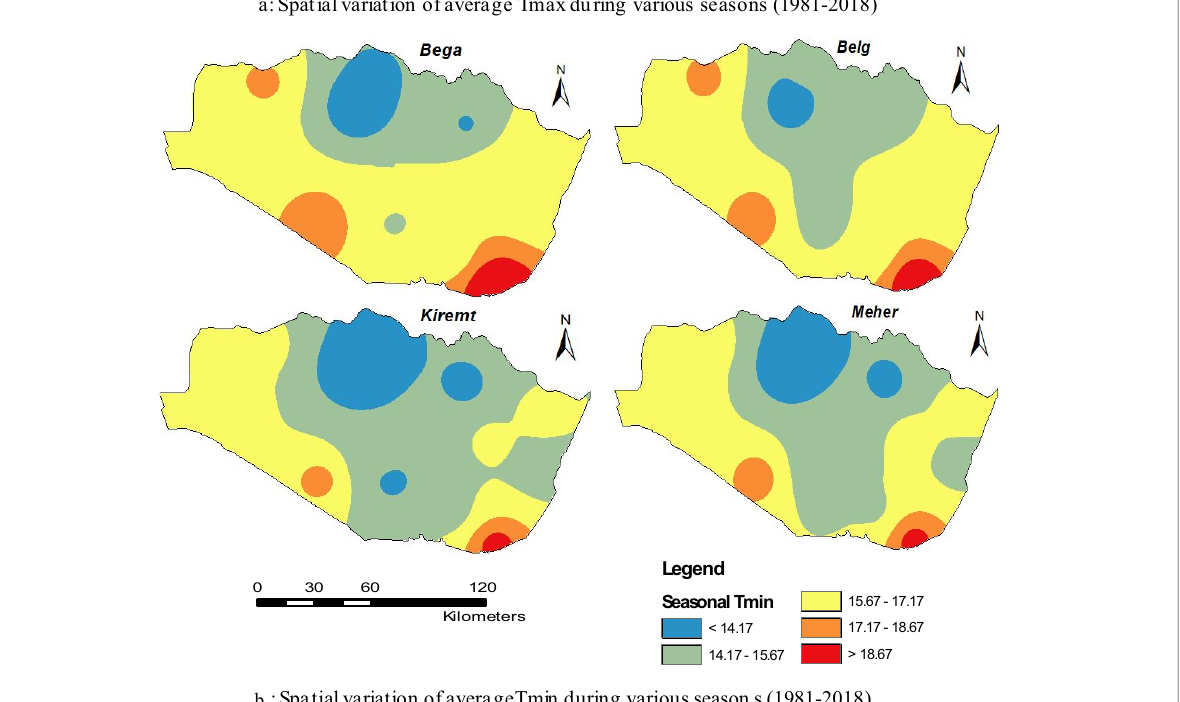
Fig. 8 a Spatial variation of average Tmax during various seasons (1981–2018). b Spatial variation of average Tmin during various